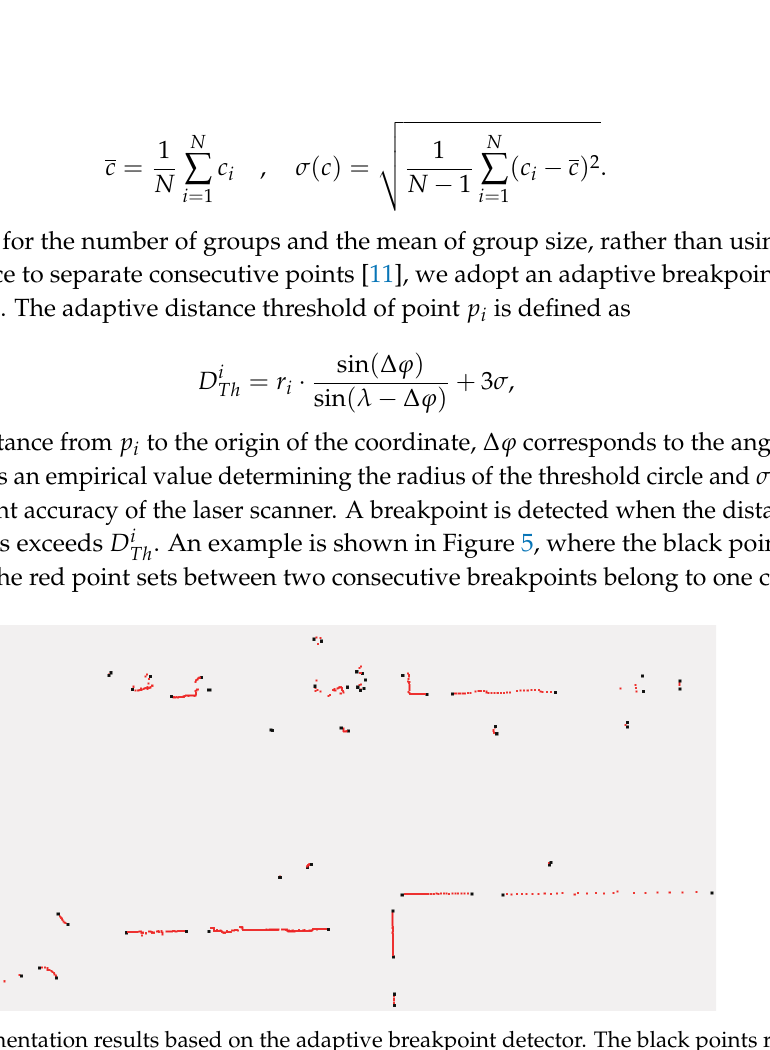
Figure 5. Segmentation results based on the adaptive breakpoint detector. The black points represent breakpoints and the red point sets between two consecutive breakpoints belong to one cluster.